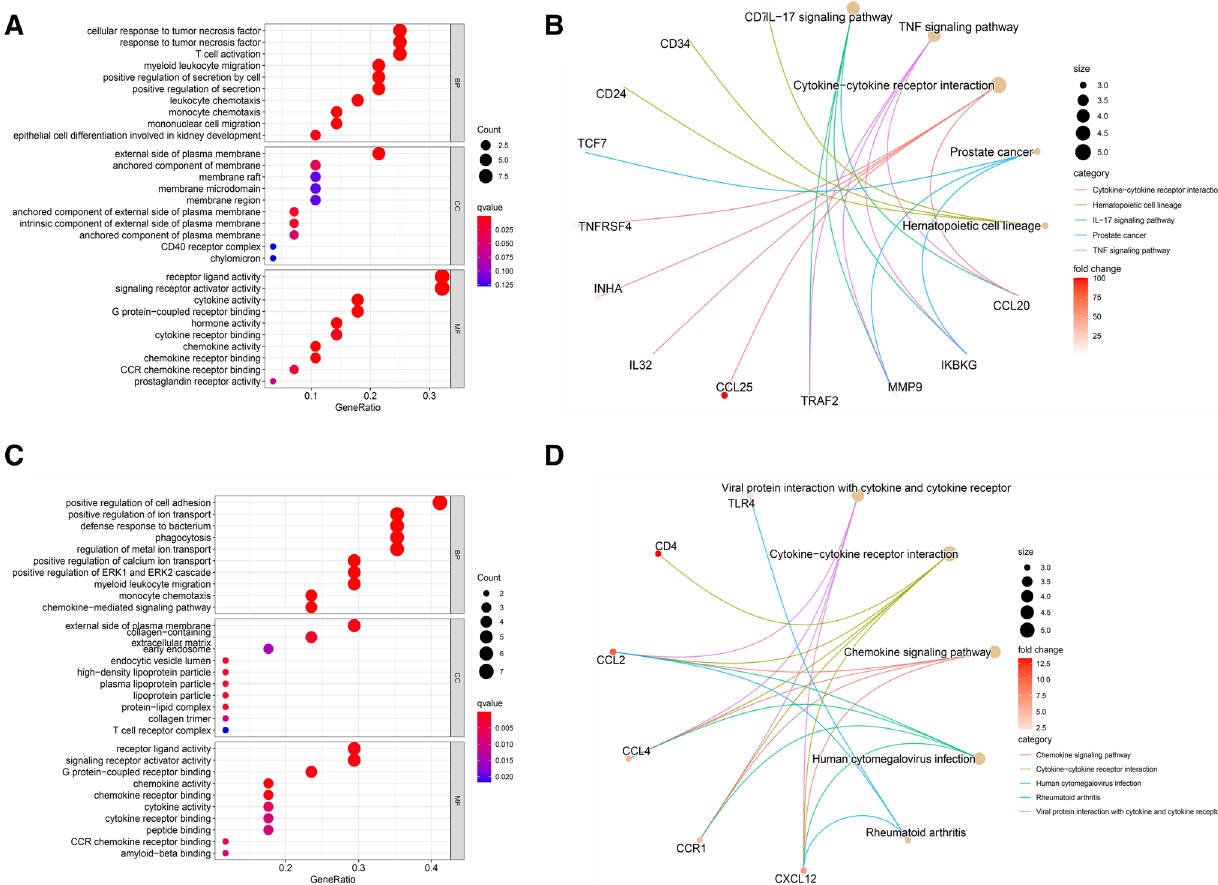
Fig. 1 Gene ontology (GO) and Kyoto Encyclopedia of Genes and Genomes (KEGG) analysis of immune-related up- and down-regulated genes in HCC. a , b showed GO and KEGG analyses of upregulated genes in HCC, respectively. c , d showed GO and KEGG analyses of down- regulated genes in HCC,